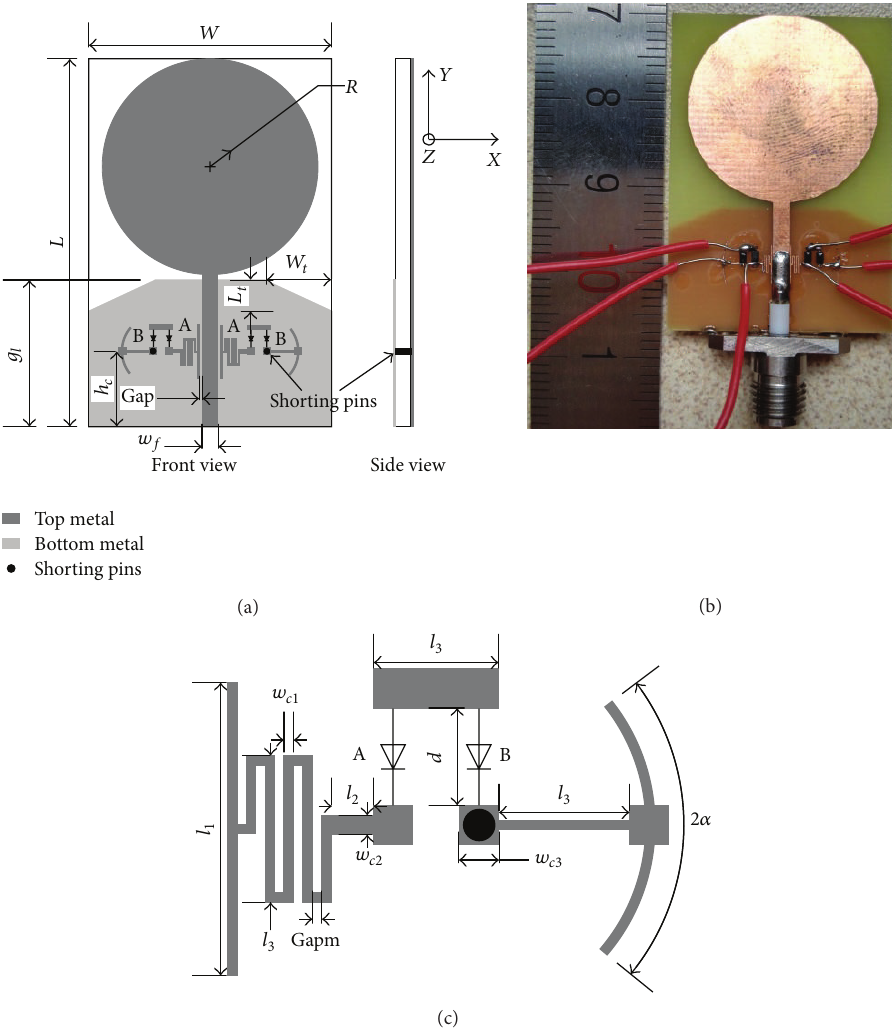
Figure 1: Geometry of the proposed switchable and tunable band-notched UWB antenna: (a) antenna structure, top view (left) and side view (right); (b) photo of fabricated prototype; (c) detailed band-notched